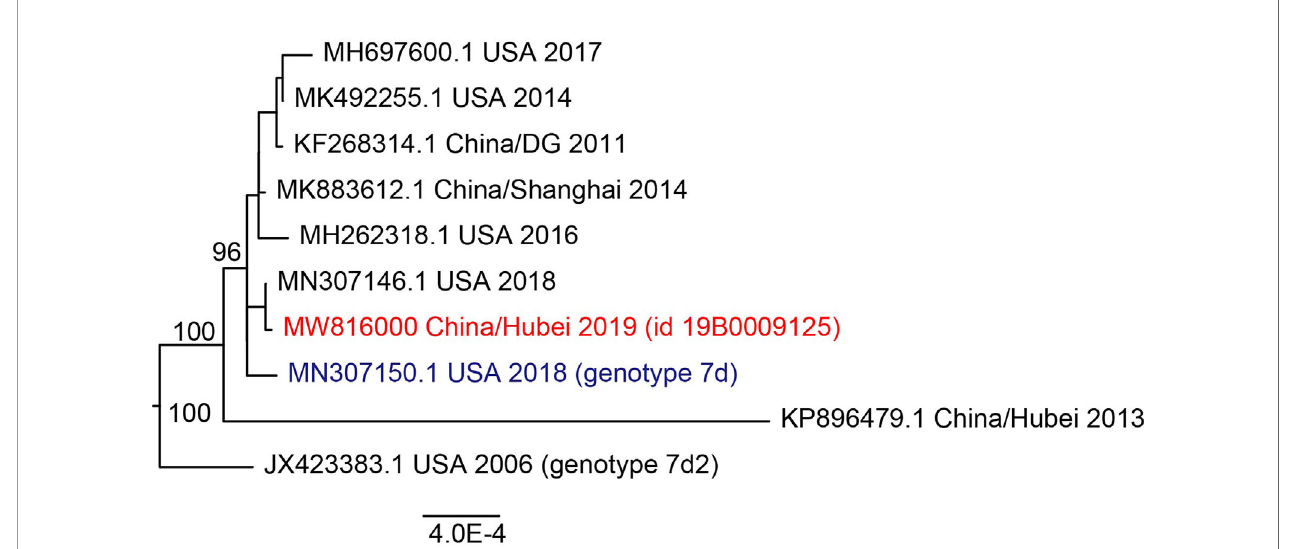
FIGURE 5 | Maximum likelihood phylogenetic tree of whole genome of HAdV 7. Viruses in this study were labeled in red and the reference sequence was labeled in blue. Bootstrap values were shown in tree